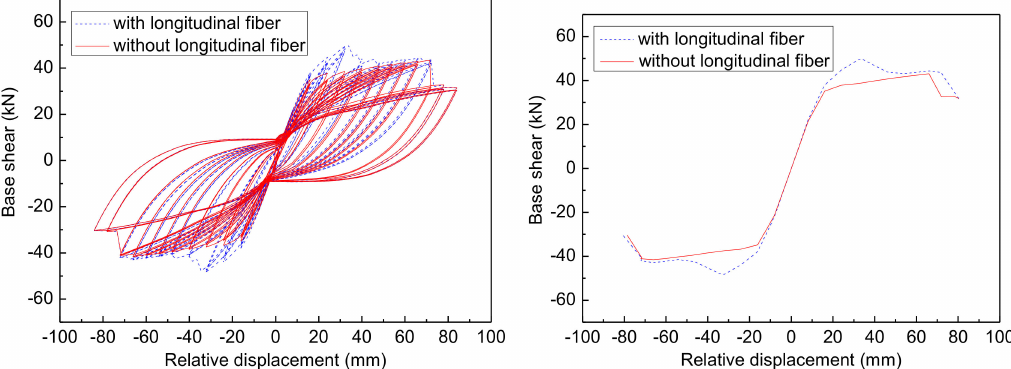
Figure 15. The hysteretic curves for column